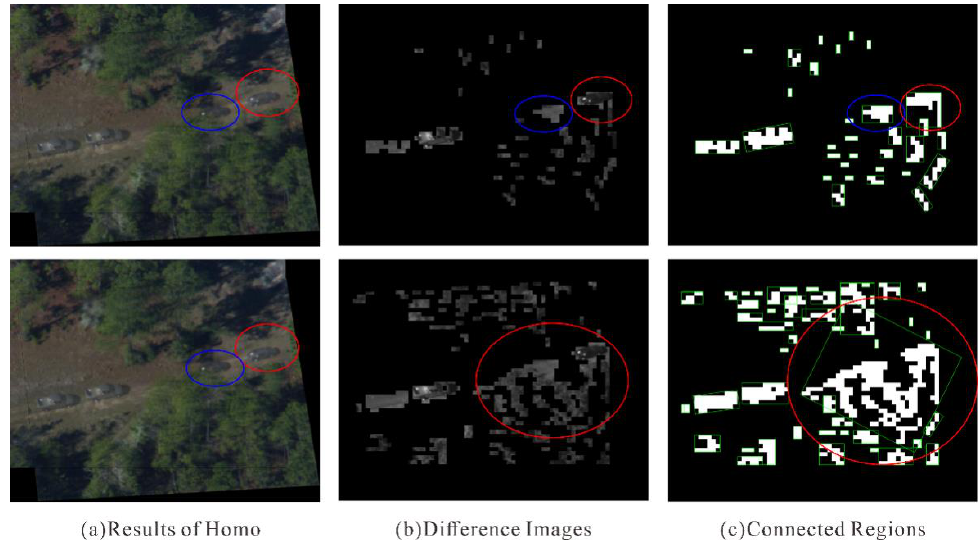
Figure 6. The comparison of threshold 𝑡 1 .